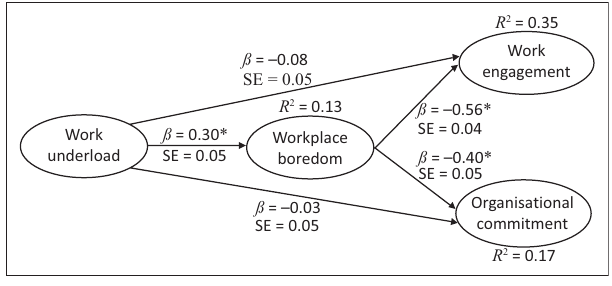
FIGURE 2: Standardised estimates for the direct relationships of the structural